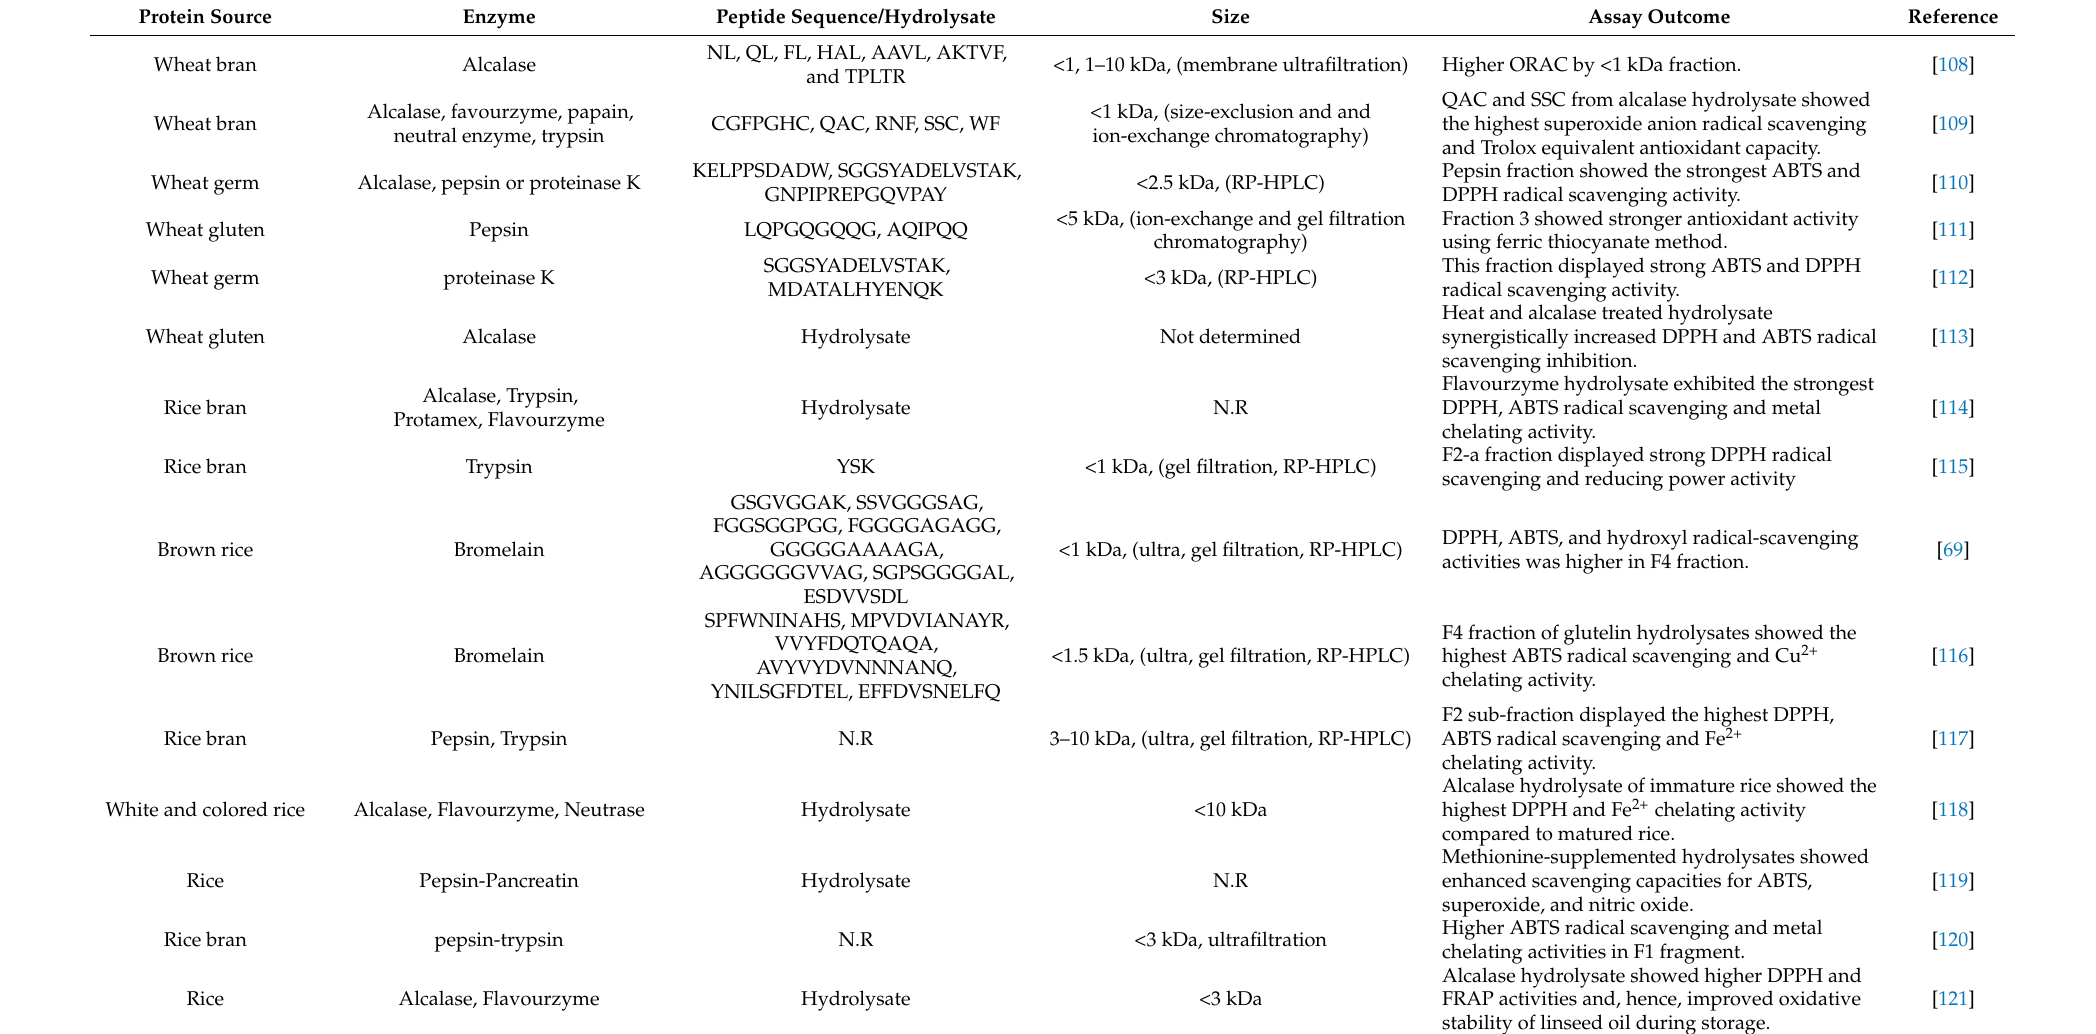
Table 4. Chemical assay showing some examples of cereal antioxidant